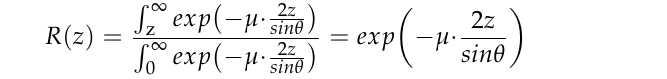
Figure 2. Absorption of the radiation in a Bragg – Brentano configuration.